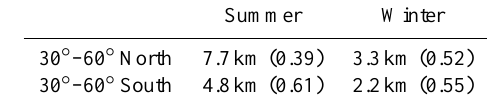
Table 1. Mid-latitude summer and winter median distances to clouds and, in parentheses, cloud fractions for low clouds based on the MODIS cloud mask. Winter and summer data are based of the 1 December–28 February or 1 June–31 August periods, depending on the hemisphere.